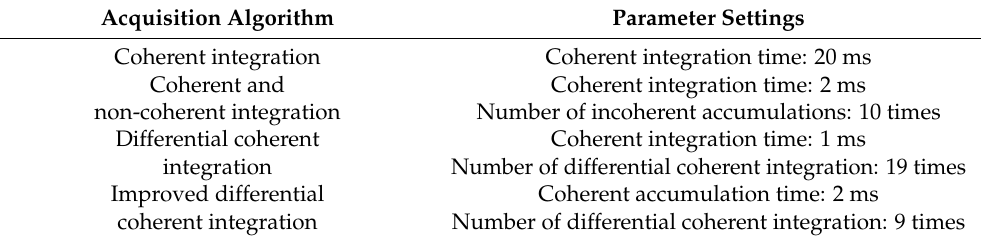
Table 1. Experimental acquisition algorithm-specific settings.